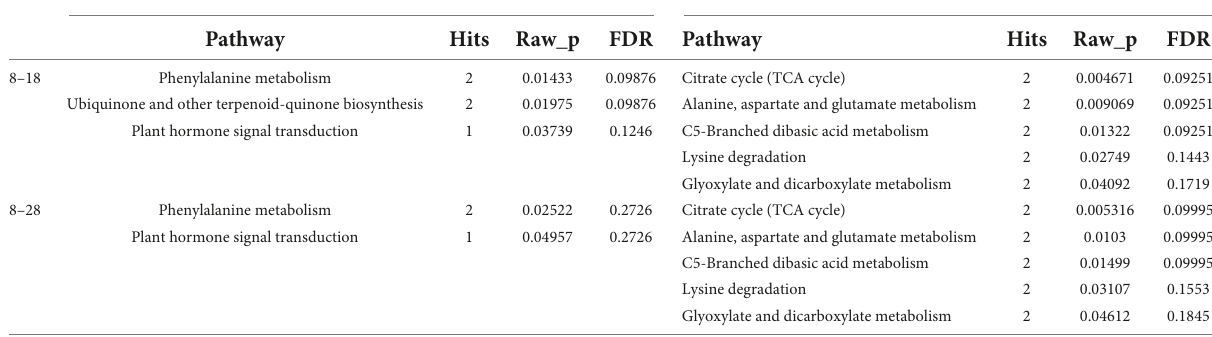
TABLE 2 Negative analysis significant enrichment of KEGG